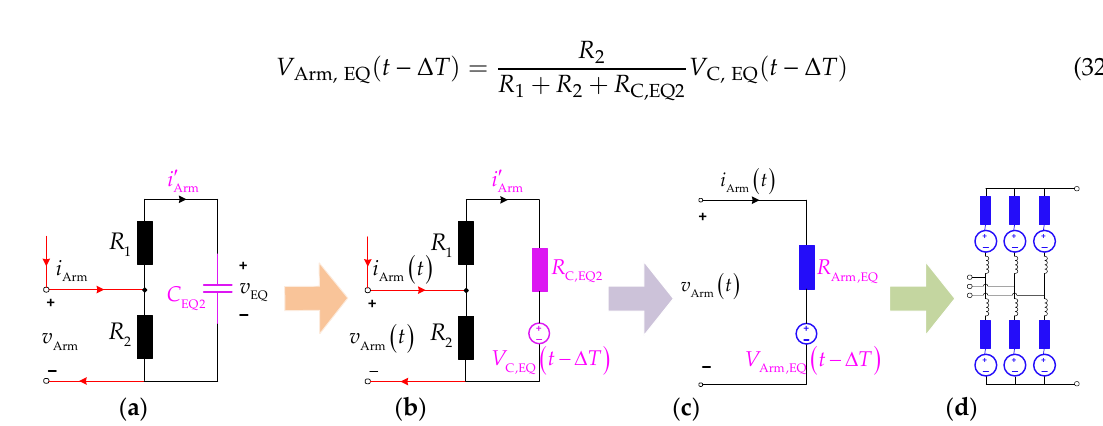
Figure 6. The Thévenin equivalent process: ( a ) The arm equivalent circuit based on arm current; ( b ) The arm equivalent circuit with R C, EQ2 discrete companion model; ( c ) Thévenin equivalent circuit of the arm; ( d ) The equivalent circuit of the MMC.